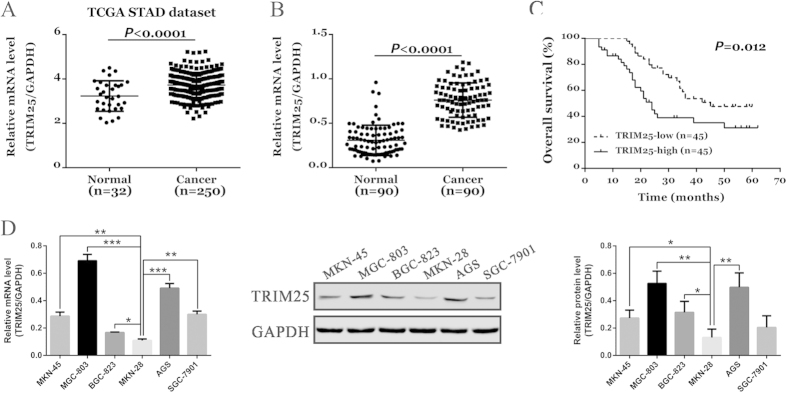
Overexpression of TRIM25 in GC.(A) The gene expression data RNA-Seq analysis of TRIM25 mRNA expression in GC tissues (n = 32) and normal tissues (n = 250). RNA-Seq analysis used data download from TCGA (P < 0.0001). (B) The mRNA level of TRIM25 in 90 pairs of GC and normal tissue was detected by qRT-PCR. TRIM25 mRNA was significantly overexpressed in GC tissues as compared with non-tumorous tissues (P < 0.0001). (C) Overall survival analysis showed that TRIM25 lower expression tumors have a better prognosis than TRIM25 higher expression tumors (P < 0.05). (D) Expression levels of TRIM25 were checked in a panel of 6 human GC cell lines using qRT-PCR method (left panel) and immunoblotting (middle and right panels). Representative immunoblotting (middle panel) and quantitative results (right panel) were shown (*P < 0.05, **P < 0.01, ***P < 0.001).